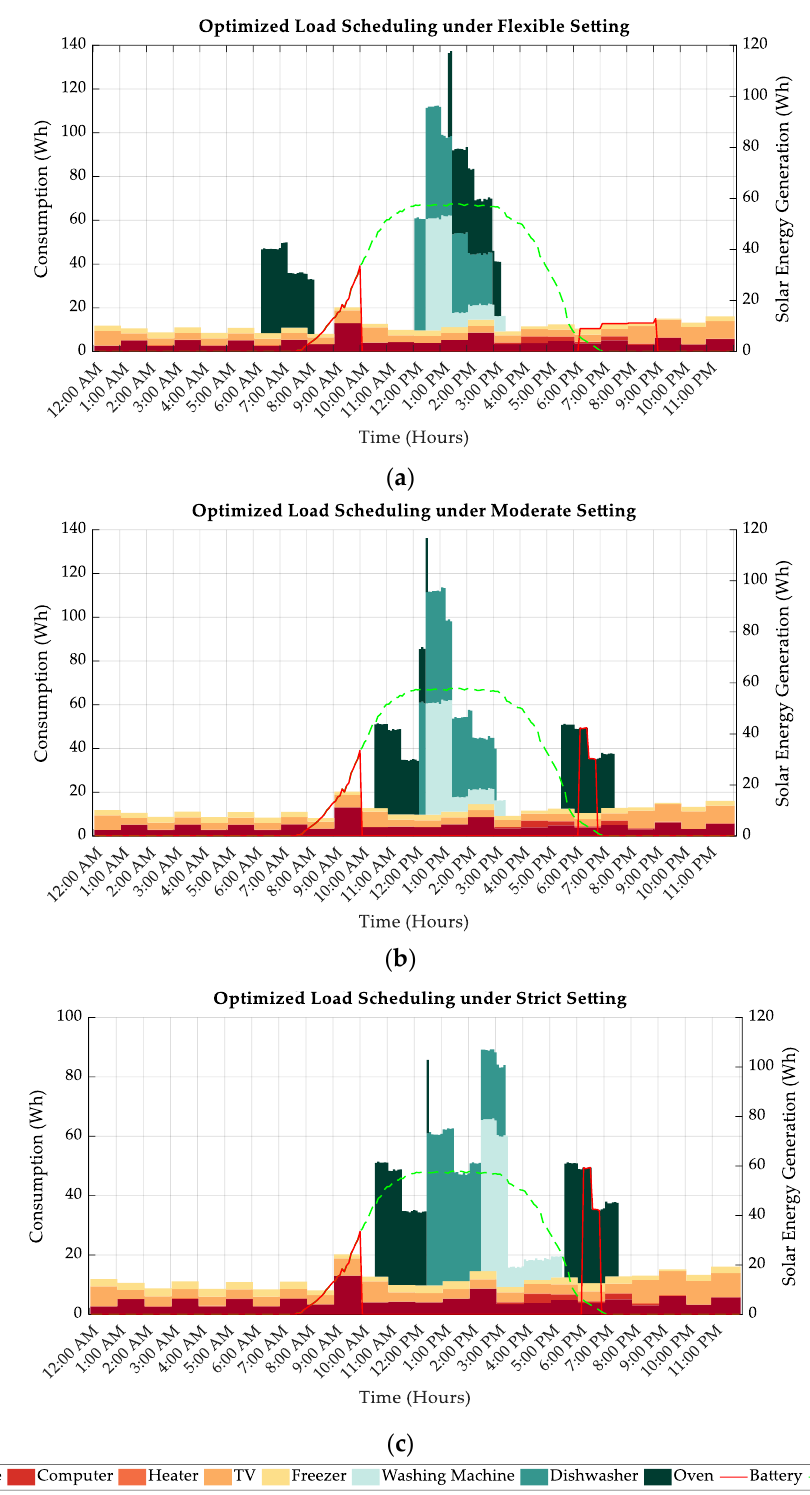
Figure 6. Resulting Load Profiles from Scenario 3. ( a ) Load Scheduling for the Flexible Setting; ( b ) Load Scheduling for the Moderate Setting; ( c ) Load Scheduling for the Strict Setting.